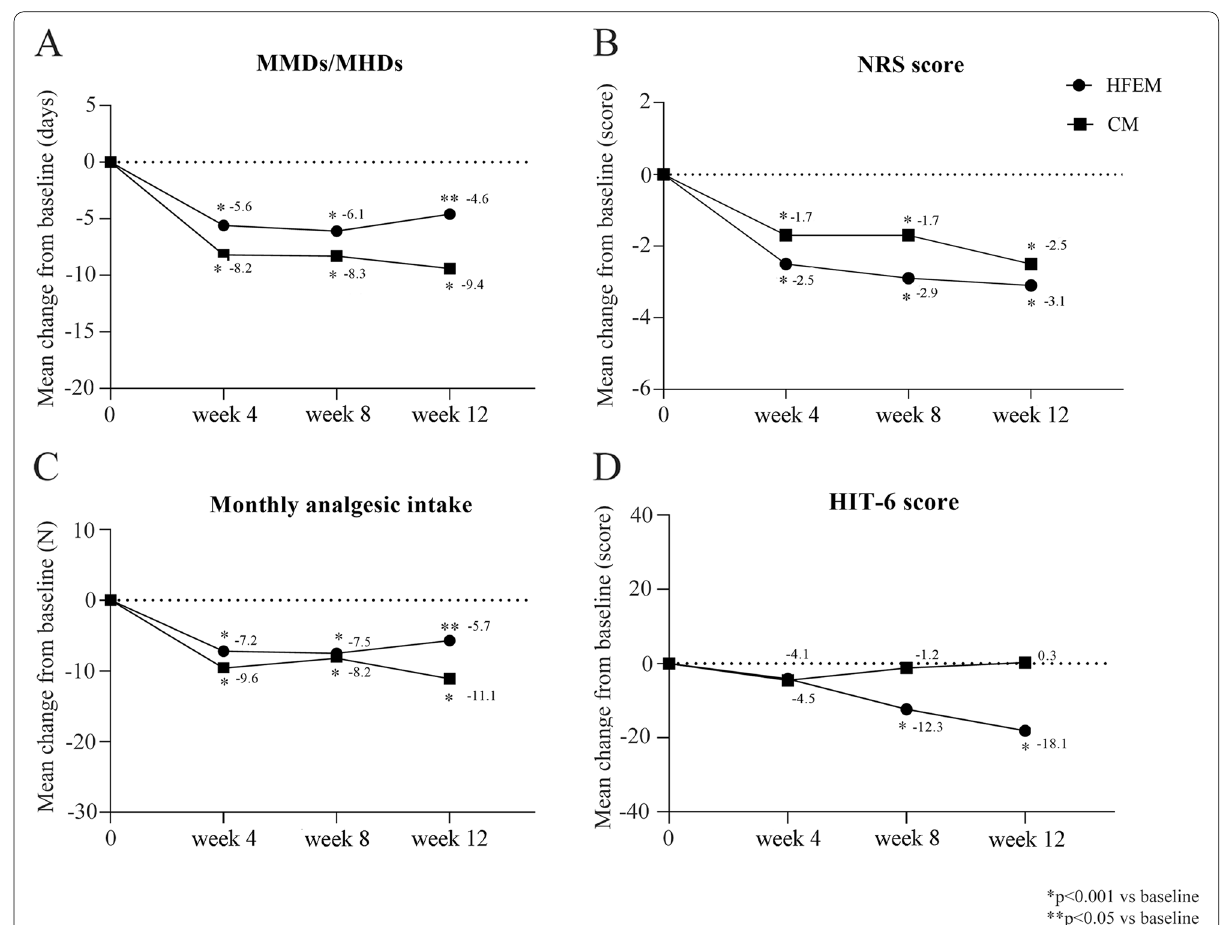
Fig. 2 Mean change in A monthly migraine days/monthly headache days (MMDs/MHDs), B Numerical Rating Scale (NRS), C monthly analgesic intake, and D Headache Impact Test-6 (HIT-6) score from baseline to Week 12. CM, chronic migraine; HFEM, high-frequency episodic migraine